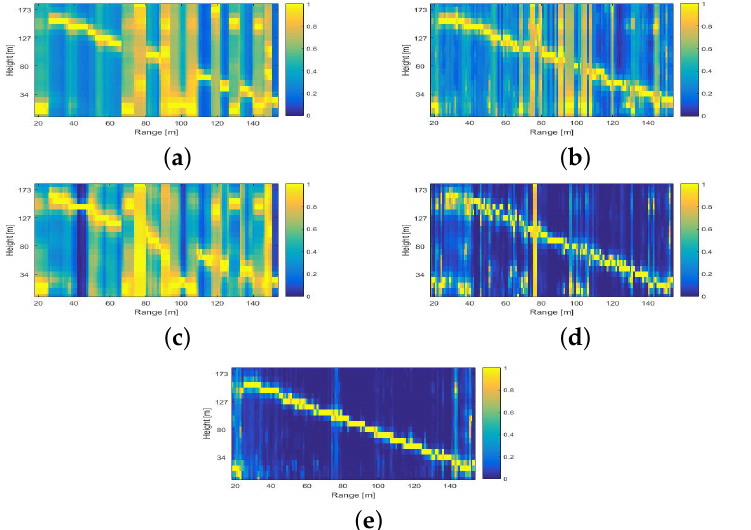
Figure 9. Tomograms of the green azimuthal line generated by the ( a ) Standard MUSIC estimator, ( b ) BIC-MUSIC estimator, ( c ) Minimum-Norm estimator, ( d ) Regularized Minimum-Norm estimator, and ( e ) proposed non-parametric MUSIC